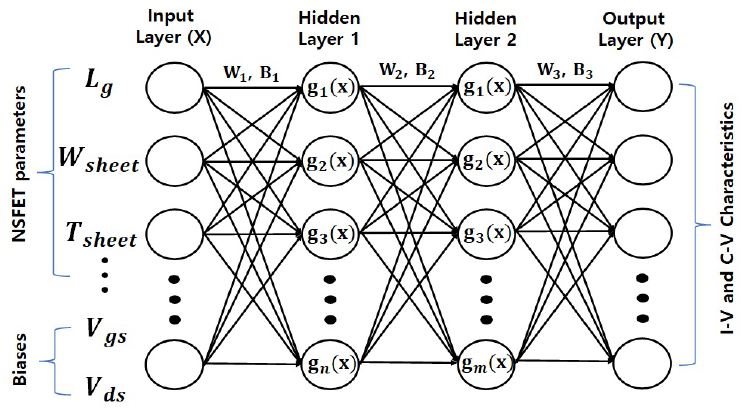
Figure 5. The proposed ANN model’s